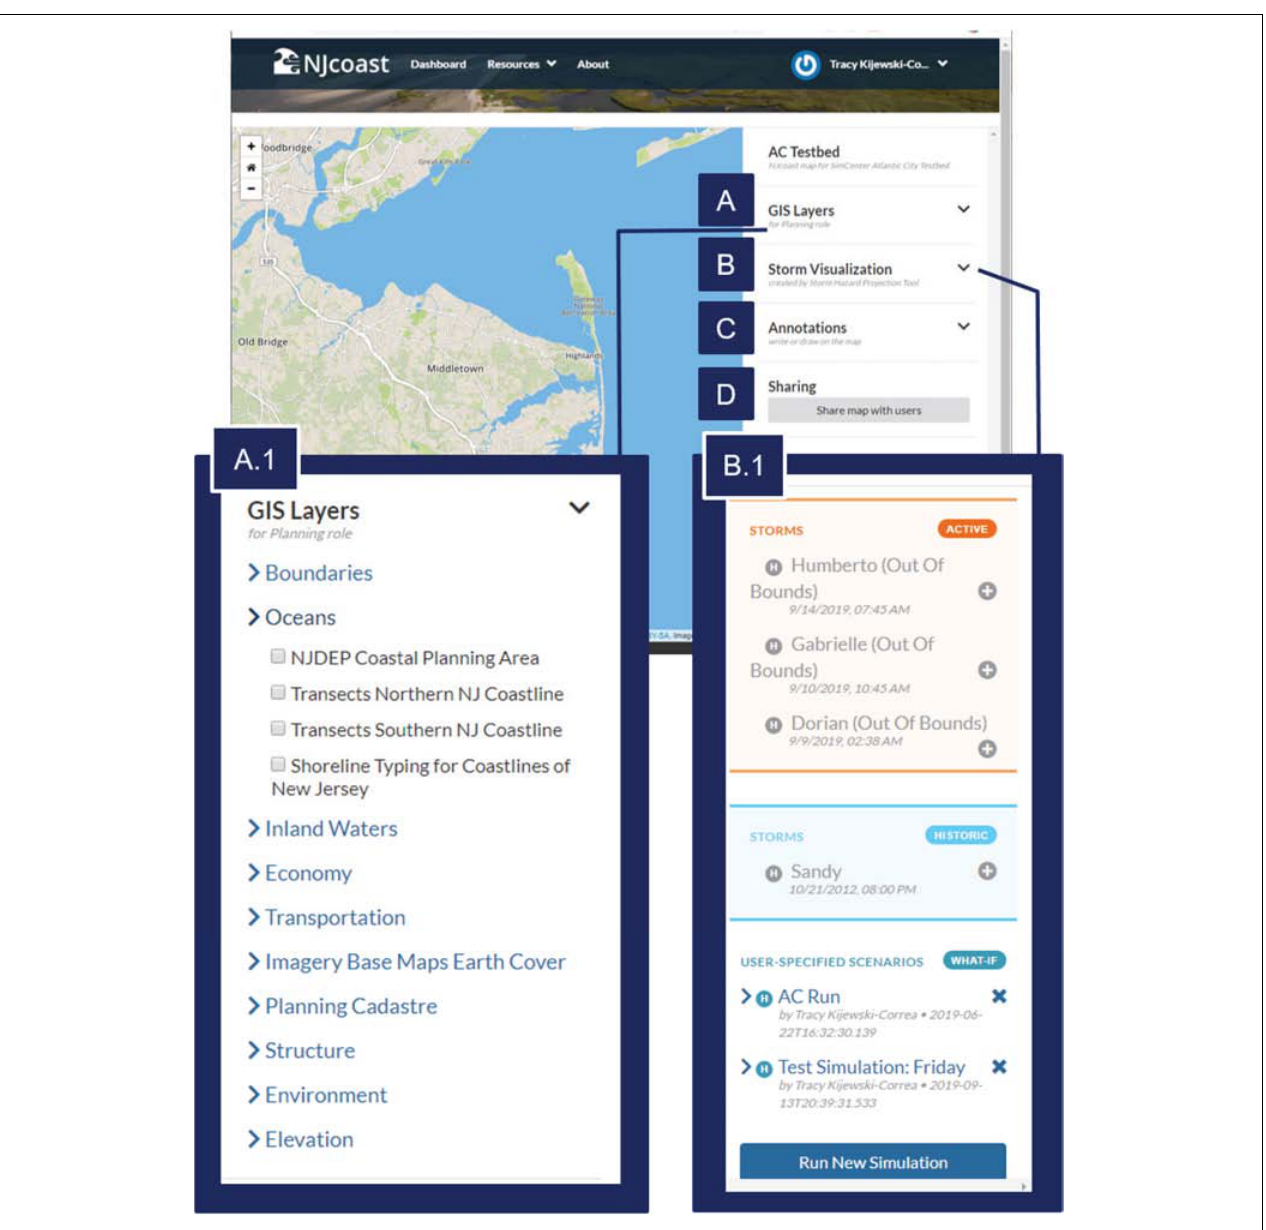
FIGURE 3 | NJcoast Map View with four menus: (A) GIS layer, (B) Storm visualization, (C) Annotation, and (D) Sharing. Callout (A.1) shows an example of the ISO 19115 categories under the GIS layers menu and specifically the pre-loaded GIS layers displayed under the Oceans Category for a planner with no specific municipal affilition. Callout (B.1) shows an example of the three types of storm simulation results loaded into this user’s map: Active storms (screen capture was taken during the 2019 Hurricane season), Historic storms (Superstorm Sandy), and User-Specified Scenarios (two What-If scenarios uniquely named and saved by the user). Pressing “Run New Simulation” allows the user to add yet another What-If storm scenario to this map at any